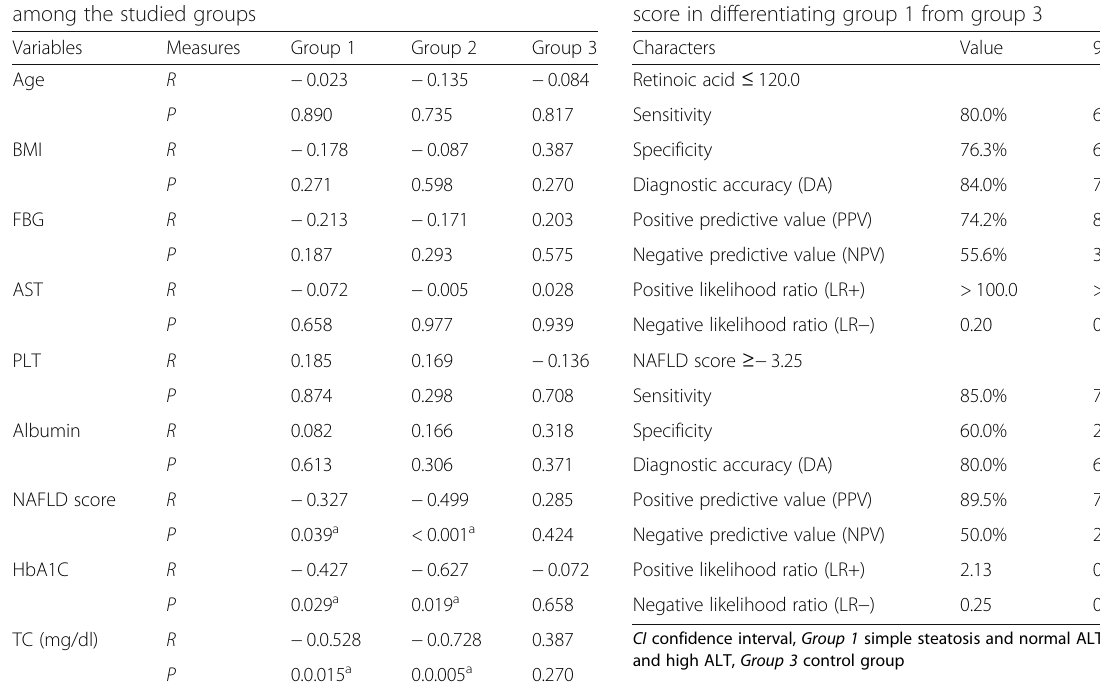
Table 5 Diagnostic characteristics of retinoic acid and